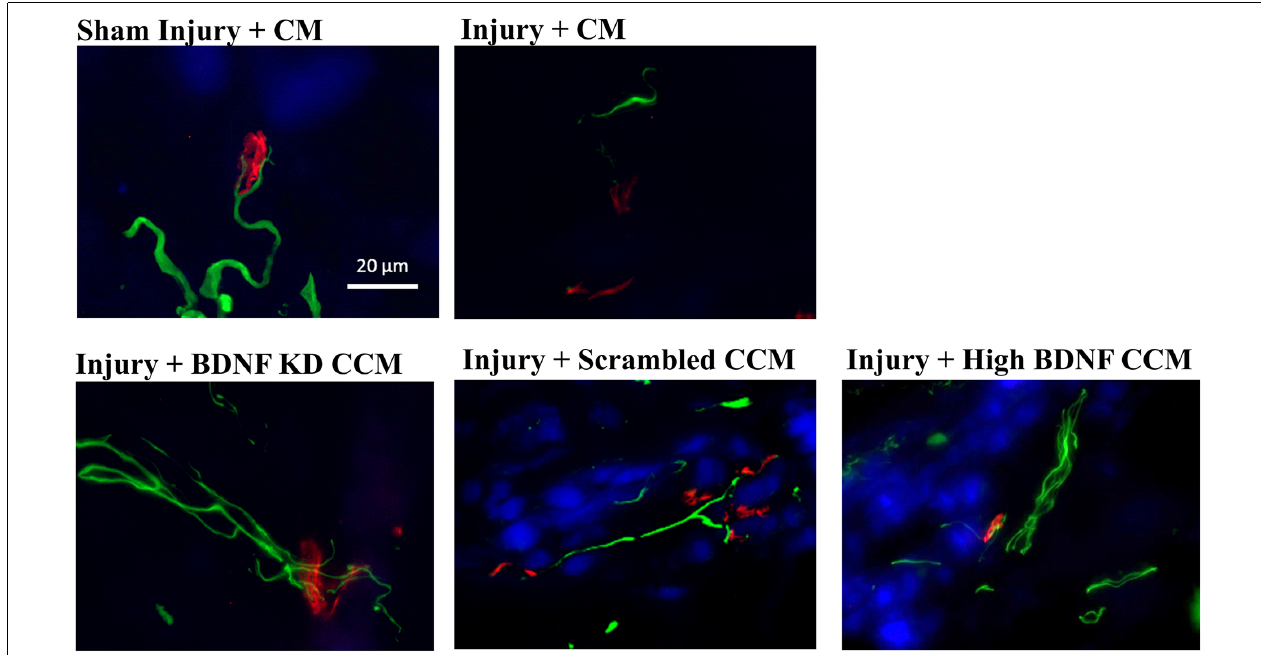
FIGURE 5 | Examples of external urethral sphincter neuromuscular junction staining from each group: Sham Injury + Control Media (CM), Injury (Pudendal Nerve Crush + Vaginal Distension) + CM, Injury + Brain-Derived Neurotrophic Factor Knockdown (BDNF KD) Concentrated Conditioned Media (CCM), Injury + Scrambled